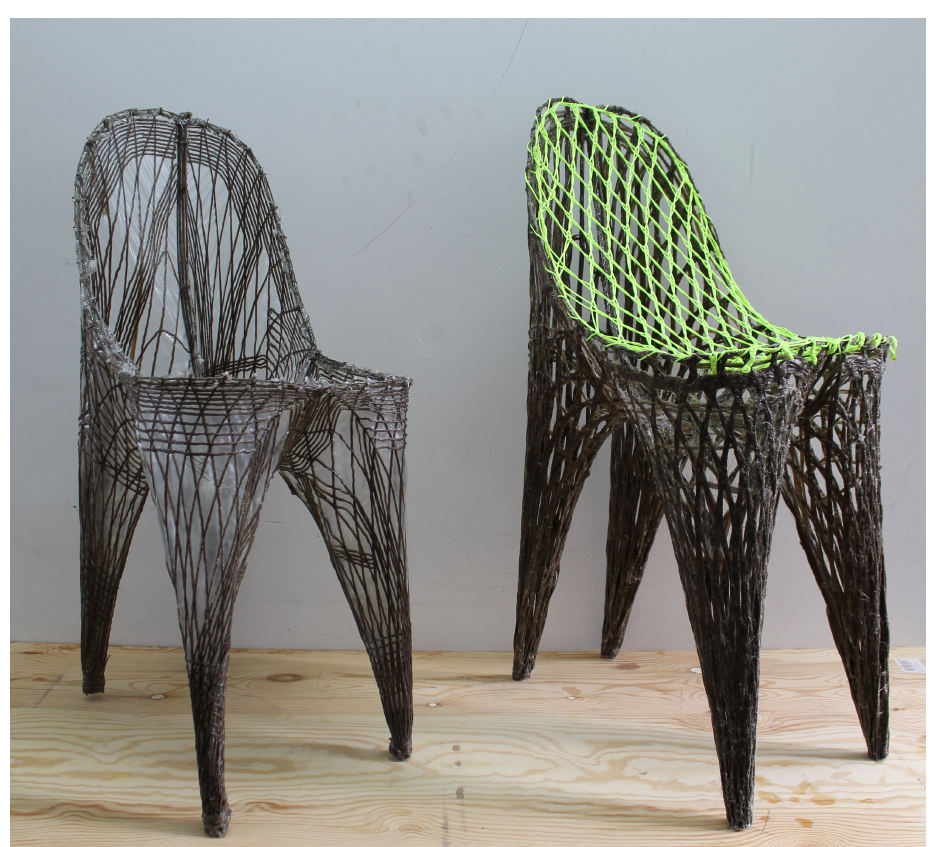
Figure 26. Two prototypes (From left to right: Prototype fabricated with automated TFP machine, Tailored lace prototype fabricated by traditional bobbin lace